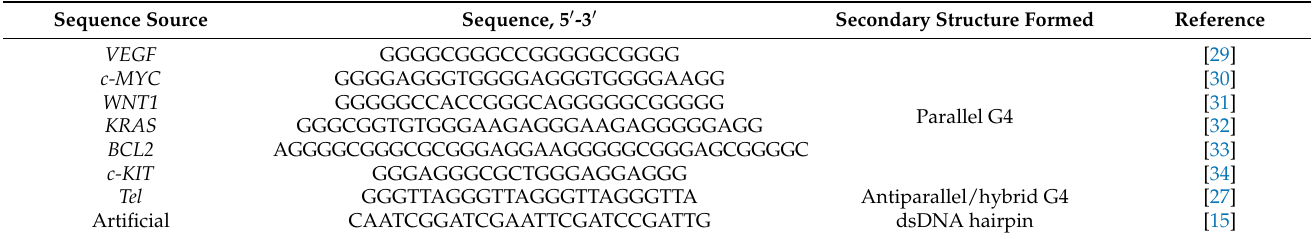
Table 1. The DNA sequences of oligonucleotides used in the